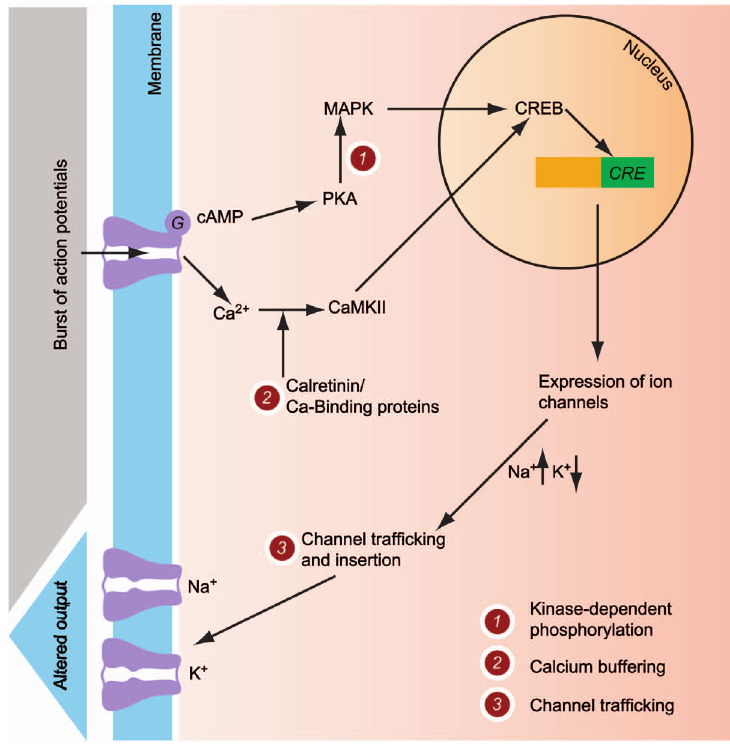
Figure 3 Putative molecular substrates of intrinsic excitability. Several intracellular signaling molecules have been shown to contribute to intrinsic excitability. In this example, a burst of presynaptic action potentials produces both an influx of calcium ions across the neuronal cell membrane and activation of cAMP. Calcium/cAMP activate protein kinases A, C, and/or CaMKII to phosphorylate cAMP response element binding protein (CREB). Phosphorylation of CREB increases binding to a specific DNA sequence called the cAMP response element (CRE), present in the promoter of many genes, and subsequently initiates gene expression. CRE-driven gene expression has been shown to result in both synaptic and intrinsic modifications including altered regulation of sodium and potassium channel expression, and subsequent alterations in neuronal